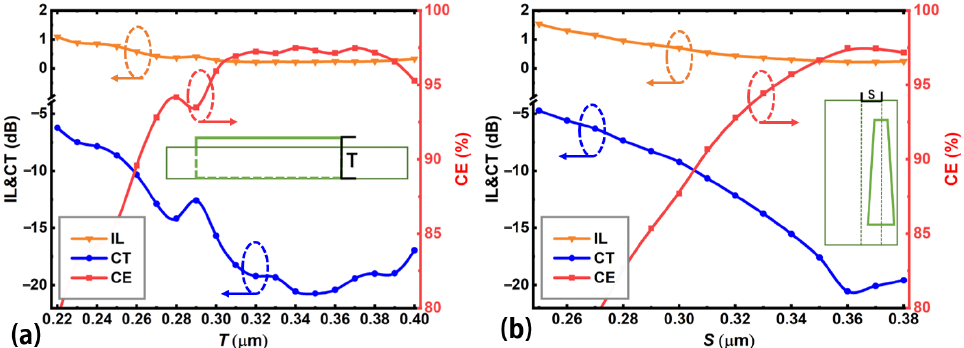
Figure 5. Device performance (mode CE, CT, and IL) as functions of the ( a ) Sb 2 Se 3 layer thickness T and ( b ) lateral shift S of the embedded Sb 2 Se 3 layer relative to the centerline of the waveguide. Insets show the definition of the device parameters being calculated.